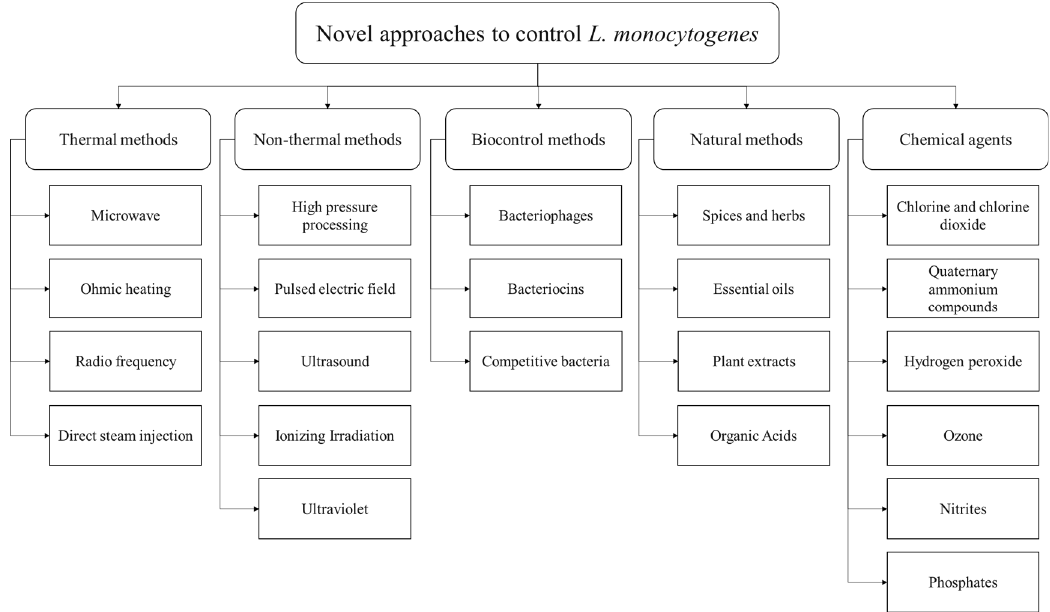
Figure 3. Novel approaches to control L. monocytogenes in food products and food production environments, categorized as thermal methods, non-thermal methods, biocontrol methods, natural methods, and chemical agents.